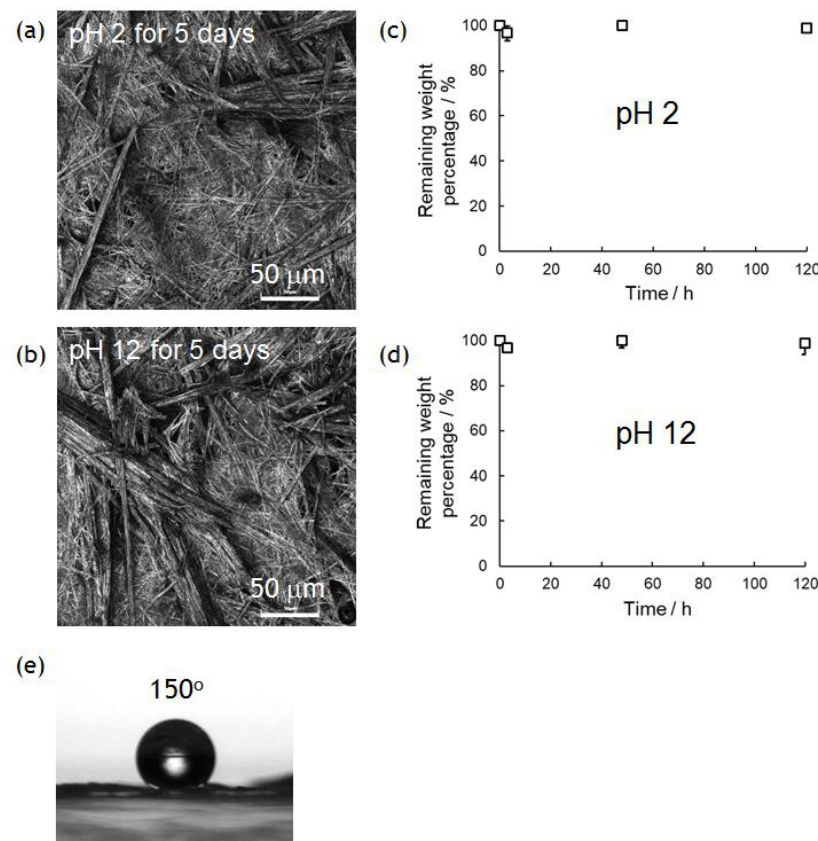
Figure 5. Chemical stability of PolyPhe nonwovens prepared by electrospinning into hexane/CHCl 3 (9/1 v / v ) in acidic (pH 2) and basic (pH 12) conditions. ( a , b ) Weight remaining ( n = 3) and ( c , d ) LM images of the PolyPhe nonwovens after 5 days’ immersion in ( a , c ) 0.01 M HCl aq. and ( b , d ) 0.01 M NaOH aq. ( e ) The CA of a water droplet on the PolyPhe nonwovens after the alkali treatment.